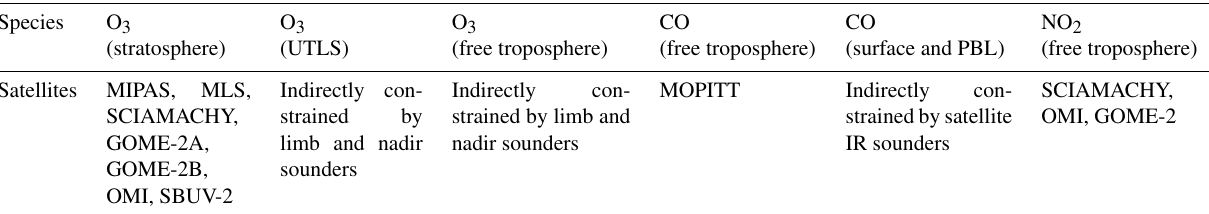
Table 2. The satellite datasets of trace gases assimilated in CAMSRA. Species O 3